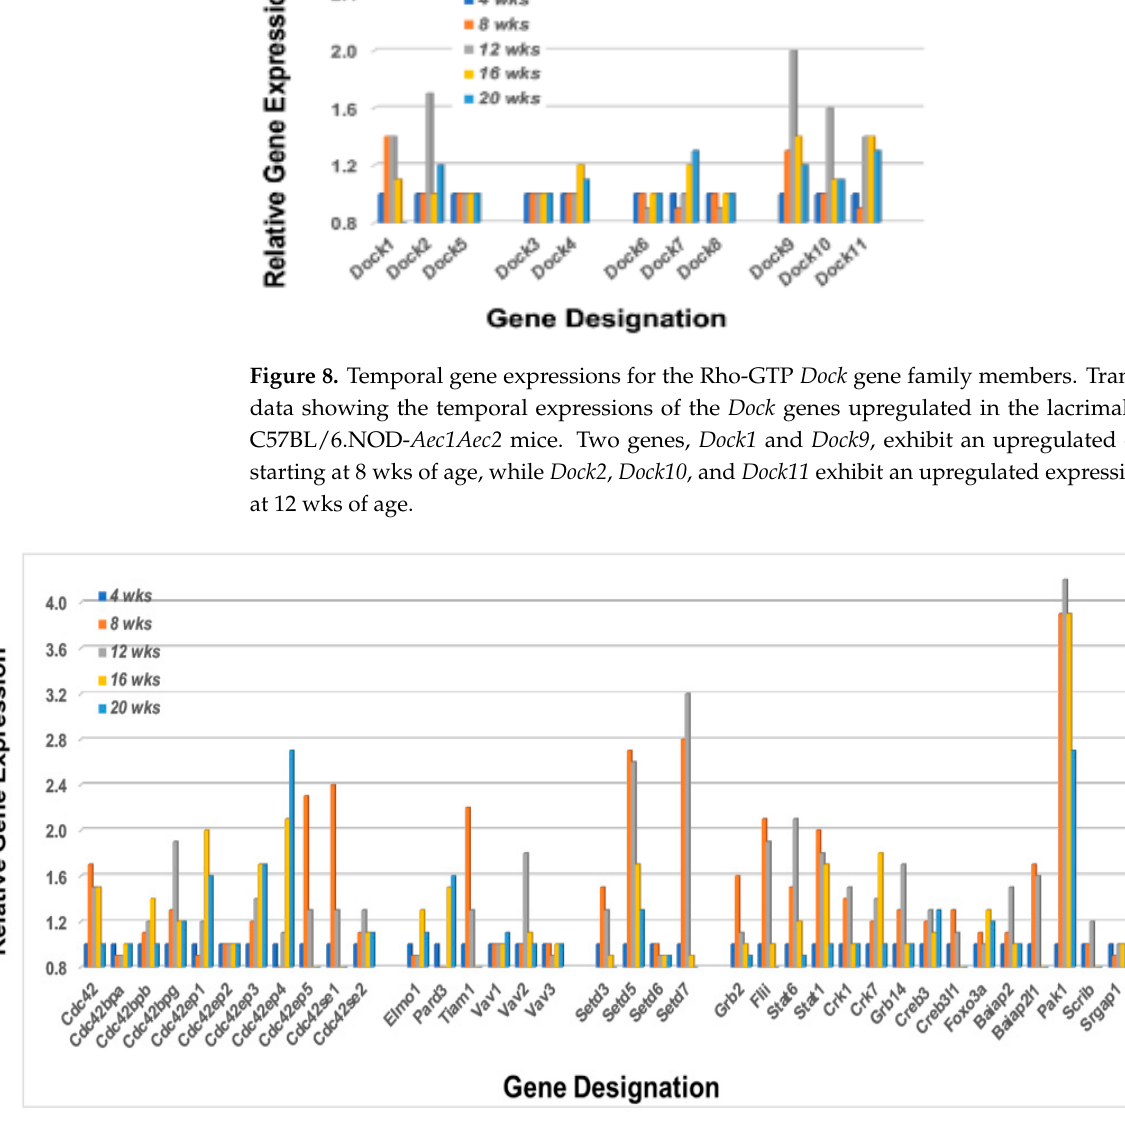
Figure 9. Temporal gene expressions for various proteins important in signal transduction pathways involving the Rho-GTPases. Transcriptome profiles for multiple family genes (e.g., Cdc42 , Vav , Setd , Crkb , Stat , Crk , and Baiap )), plus individual genes (e.g., Tiam1 , Grb2 , Flii , Creb3 , Foxo3a and Pak1 ) in the lacrimal glands of C57BL/6.NOD- Aec1Aec2 mice. Examination of the temporal differential